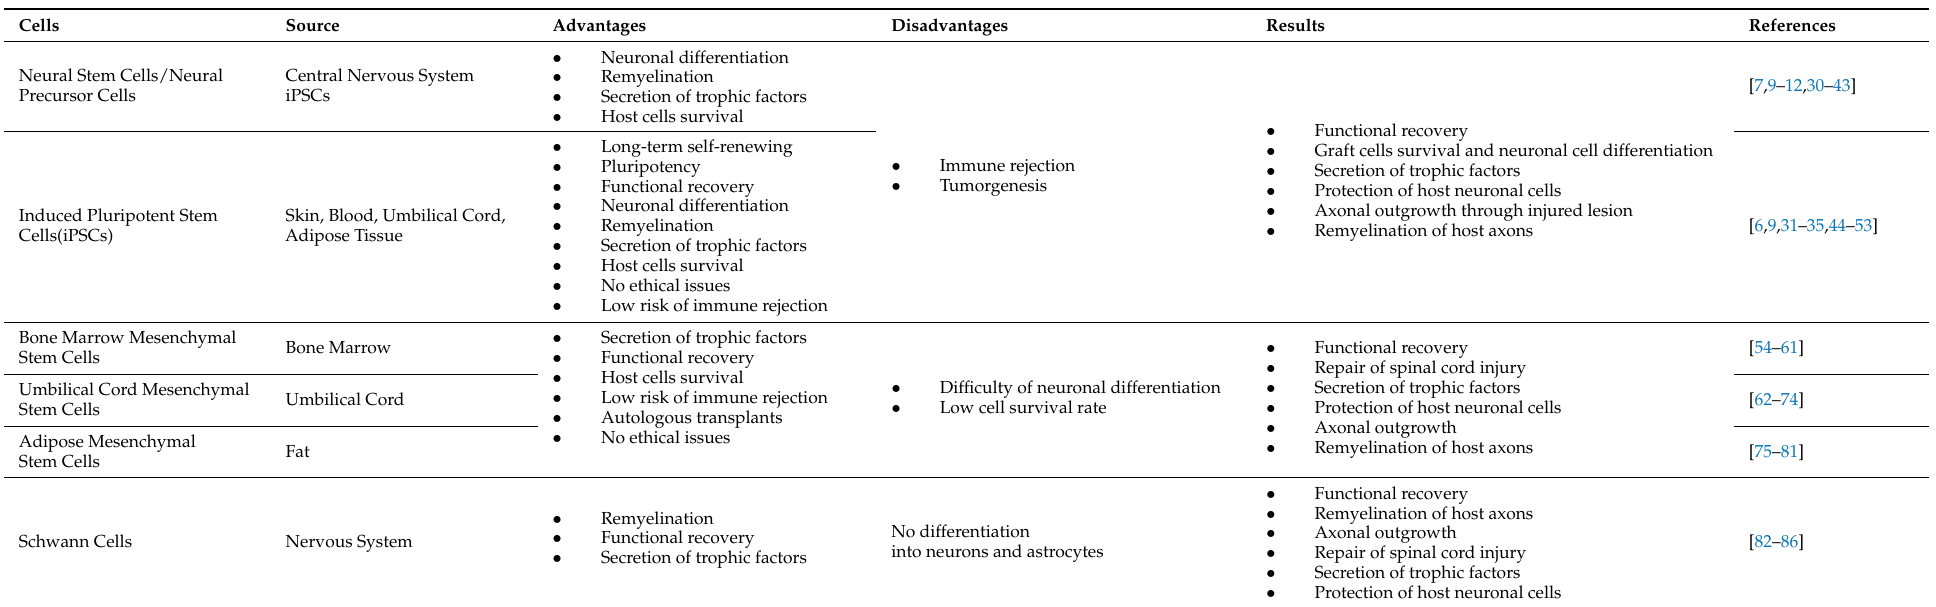
Table 2. Excellent candidates for future clinical applications, given their promising preclinical